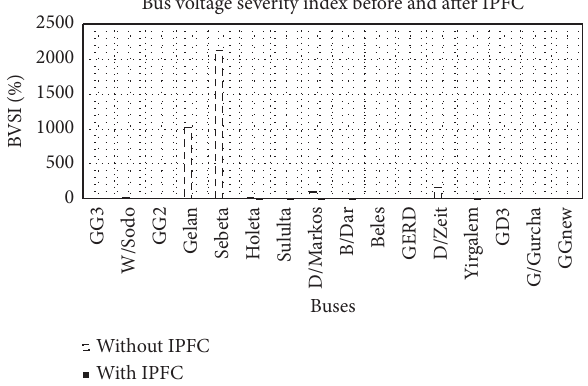
Figure 3: Bus voltage severity index before and after IPFC.